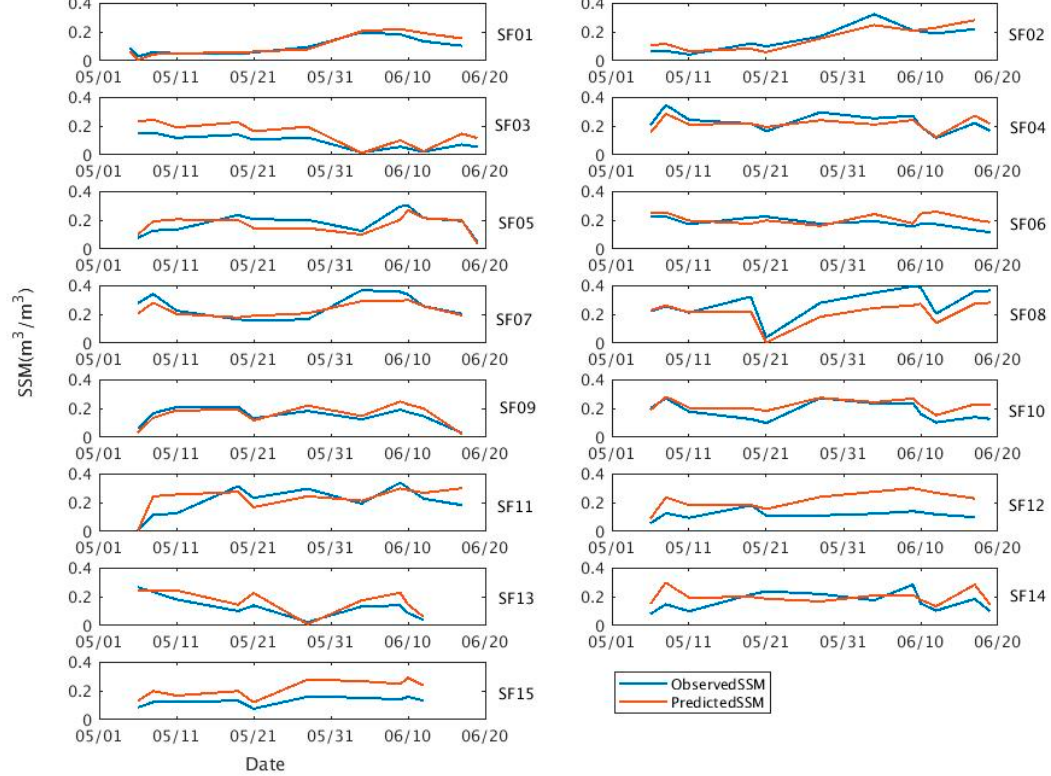
Figure 8. Time series of predicted and observed SSM.